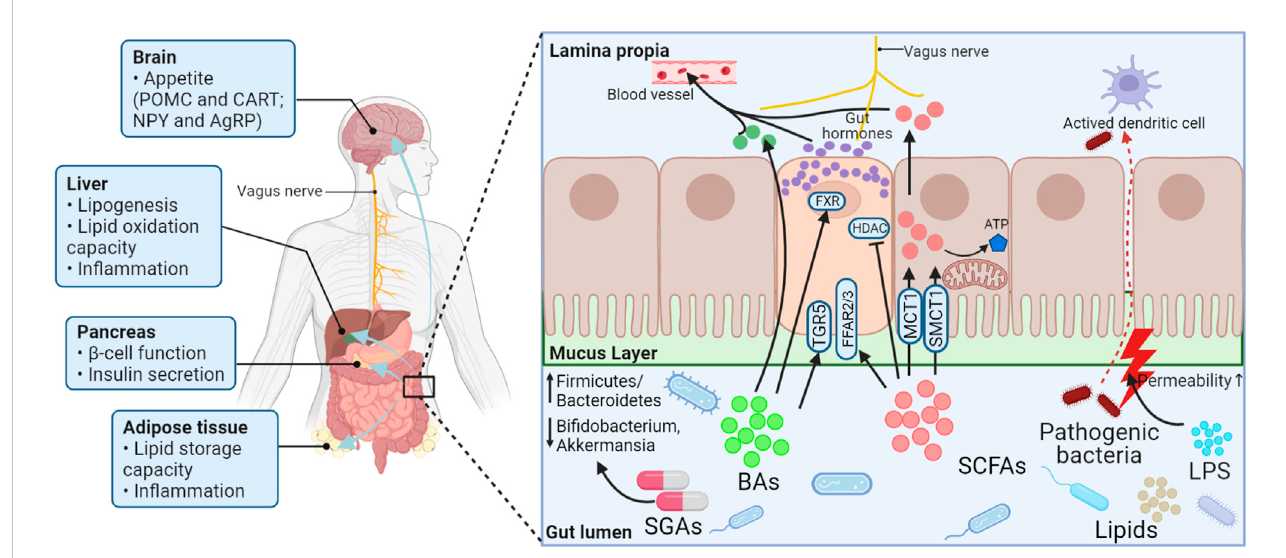
FIGURE 2 Schematic presentation of the potential mechanism of lipid metabolism disorders secondary to SGA treatment based on the gut microbiota. Treatment with SGAs may increase the relative ratio of Firmicutes to Bacteroidetes bacteria, As well as decrease the relative abundance of Bi fi dobacterium and Akkermansiamuciniphila.The products ofthegutmicrobiota(lipids,LPS, SCFAs,andBAs)changeasaresultofthistransformation.SCFAs activateFFAR2/3 or HDAC. BAs sendsignals to EEcells throughTGR5ornuclearFXR, allowingEE cells tosynthesizeand secretevarious gut hormones.LPS, SCFAs,BAs,and gut hormones are important players in interorgan crosstalk by affecting appetite, regulating gut integrity, and improving liver, pancreas, and adipose tissue function and lipid metabolism. POMC, Proopiomelanocortin; CART, Cocaine- and amphetamine-regulated transcript; NPY, Neuropeptide Y; AgRP, Agouti- related peptide; FXR,Farnesoid Xreceptor;HDAC,Histone deacetylase; ATP, Adenosinetriphosphate;TGR5, Takeda G protein-coupled receptor 5;FFAR2/3, Free fatty acid receptors 2/3; MCT1, Proton-coupled monocarboxylate transporters 1; SMCT1, Sodium-coupled monocarboxylate transporters 1; BAs, Bile acids; SCFAs, Short-chain fatty acids; LPS, Lipopolysaccharide; SGAs, Second-generation